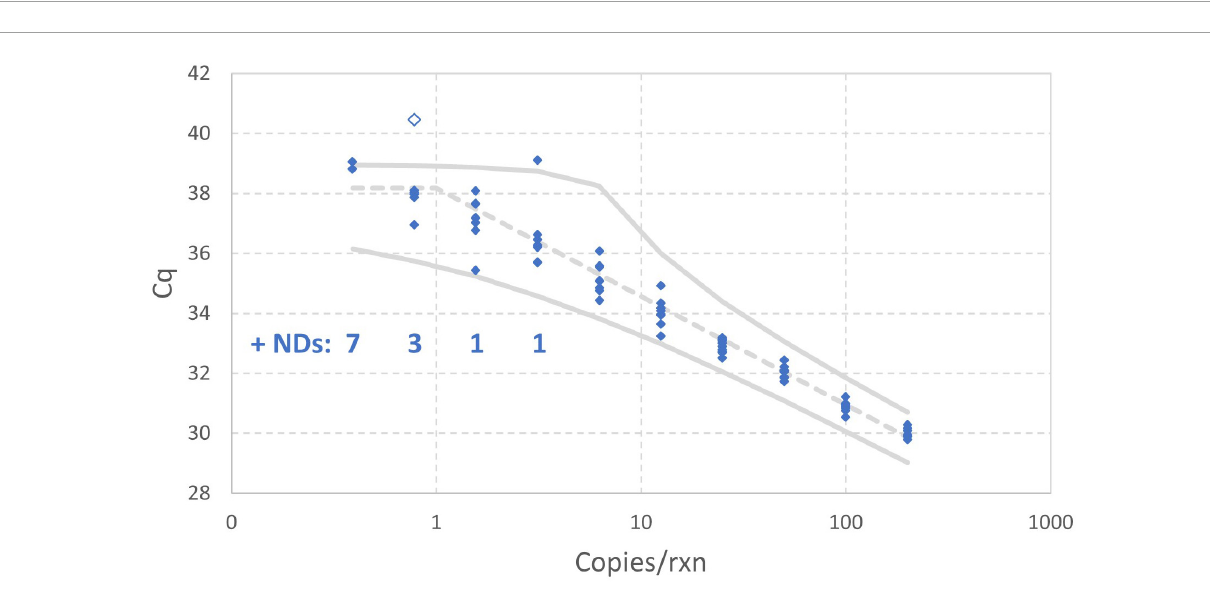
FIGURE8 Empirical standard curve data for synthetic N1 target of SARS-CoV-2 using nine technical replicates at each two-fold dilution between 0.39 and 200 gc/rxn. 95% probability intervals (solid gray) and the median (dashed gray) were computed using maximum likelihood estimates for the enhanced standard curve model with one datum excluded as an extreme